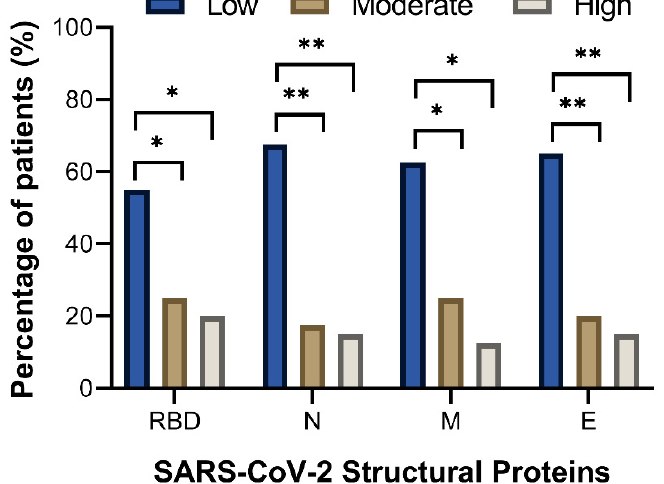
Figure 3. Levels of IgG antibodies from Mexican children and adolescents with COVID-19. IgG an- tibodies were determined by ELISA using SARS-CoV-2 RBD, N, E, and M proteins and samples from 40 patients in convalescence who had positive RT-qPCR test (Ct value), demographic, and clinical data. The negative threshold value was an optical density at 492 nm (OD 492 ) of 0.006. A low level of IgG antibodies was defined as an OD 492 of >0.06 to 0.13 for RBD protein, and an OD 492 of >0.06 to 0.17 for N, M, and E proteins. A moderate level of IgG antibodies was defined as an OD 492 of >0.13 to 0.45 for RBD protein, OD 492 >0.17 to 0.46 for N and M proteins, and OD 492 >0.17 to 0.43 for E protein. Finally, a high level of IgG antibodies was defined as an OD 492 of >0.45 for RBD protein, OD 492 >0.46 for N and M proteins, and OD 492 >0.43 for E protein. Significance was considered * p < 0.05 for RBD and M proteins, and ** p < 0.001 for N and E proteins. 3.2.3. Evaluation of Deceased Patients Who Attended HIMFG All patients who died ( n = 11) were mainly boys aged >10 years and from the hospi- talized group. This group was identified on the first wave and the beginning of the second wave of the COVID-19 pandemic (May to December 2020). Of these 11 patients, 8 (63.63%) had a severe infection and 3 (27.27%) were asymptomatic. Seven (63.63%) had a low viral load, one (9.9%) had a high viral load, and three (27.27%) were diagnosed by antigen test. Four comorbidities were detected, namely, immunosuppression ( n = 5, 45.45%), cardio- vascular disease (no hypertension) ( n = 2, 18.18%), diabetes mellitus ( n = 1, 9.9%) and chronic kidney disease ( n = 1, 9.9%); and two patients had no comorbidities. Nine (81.81%) were intubated. Interestingly, two patients with cardiovascular diseases were neonates with asymptomatic COVID-19. Fever ( n = 5, 45.45%), cough and dyspnea ( n = 4, 36.36% each) were the more frequent sign/symptoms. A 17-year-old patient with a more severe clinical history, who was intubated, was the only patient with two comorbidities (immu- nosuppression and chronic kidney disease) and presented with 11 signs/symptoms (i.e., fever, cough, dyspnea, diarrhea, thoracic pain, chills, arthralgia, polypnea, vomiting, ab- dominal pain, cyanosis, and anosmia). 4. Discussion Our national epidemiology data from children and adolescents with COVID-19 in Mexico for the 2 years of the pandemic, showed a clear increase in the incidence with age and a low mortality rate. Adolescents showed the highest incidence, similar to a previous report in Mexico [15]. In the HIMFG, COVID-19 cases were slightly higher in boys than in girls, similar to other epidemiological studies [16,17]. Nevertheless, we found a slight in- crease in the proportion of severe cases in neonates, toddlers aged >2 years, and early adolescents, compared with the rest of the age groups. Other epidemiological studies from